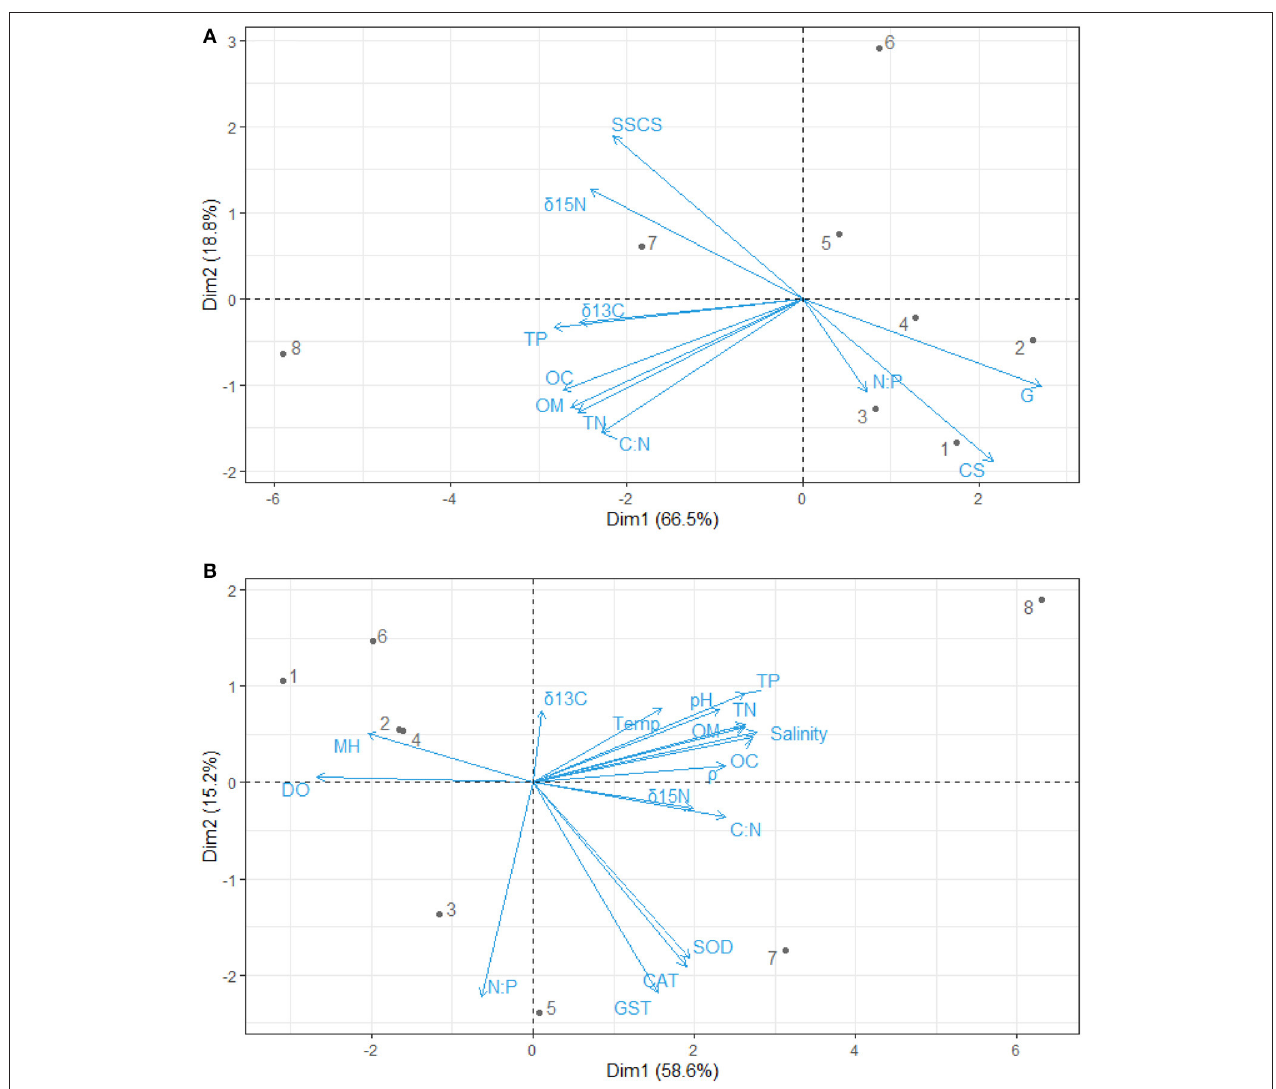
FIGURE 3 | Principal component analysis biplot for the relationship between (A) sediment grain size and nutrients (B) nutrients, physicochemical parameters, antioxidants, and mangrove height. OC, Percentage of organic carbon; TN, Total nitrate; TP, Total phosphate; C:N, Carbon-Nitrogen ratio; N:P, Nitrogen-Phosphorus ratio; δ 13 C, Carbon isotope; δ 15 N, Nitrogen isotope; CS, Coarse sandy; SSCS, Clay and Silt particles; G, Gravels; CAT, Catalase; GST, Glutathione–S–transferase; SOD, Superoxide dismutase; ρ , Density; DO, Dissolve oxygen; Temp, Temperature; MH, Mangrove height.